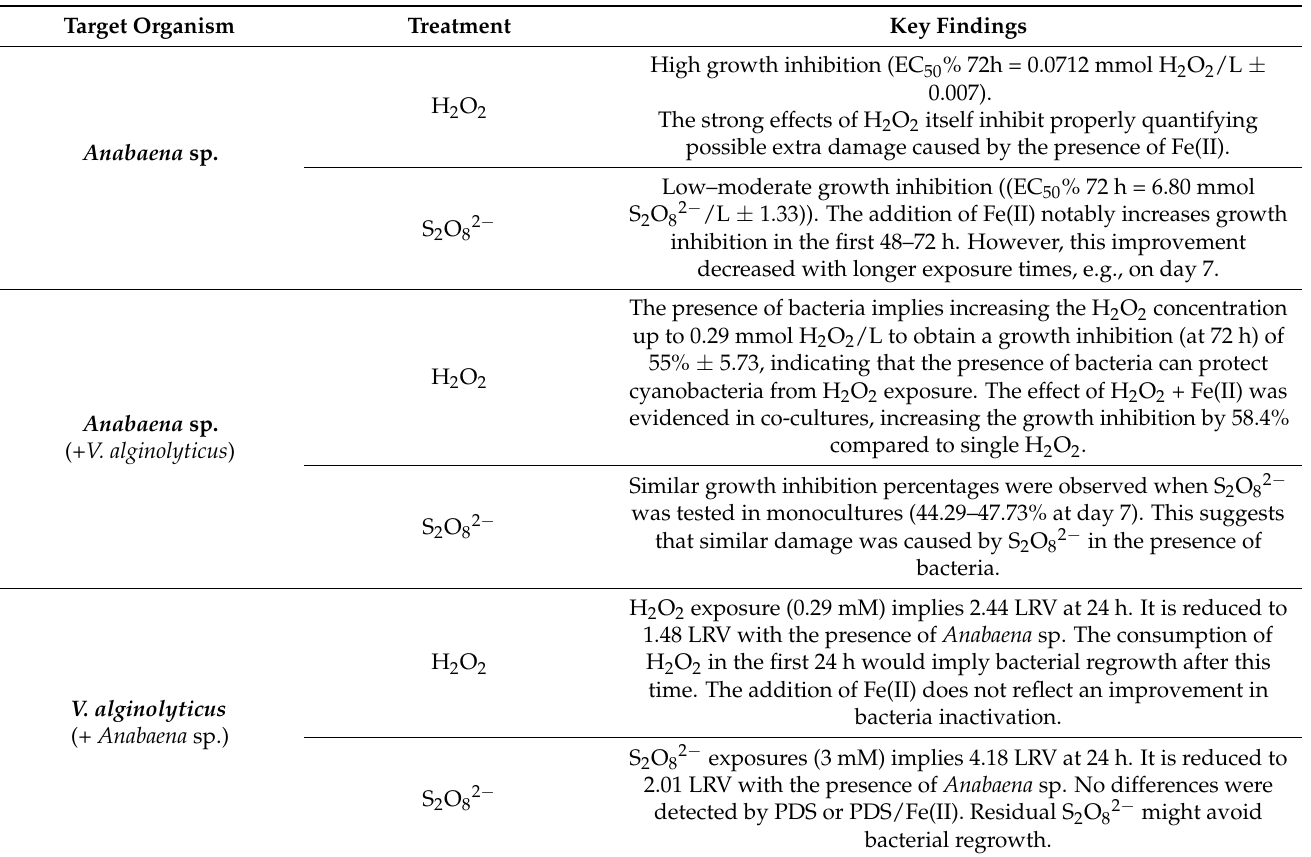
Table 2. Summary table with key findings related to the use of H 2 O 2 or S 2 O 82 − for inactivate Anabaena sp. and V. alginolyticus in (co)-cultures.